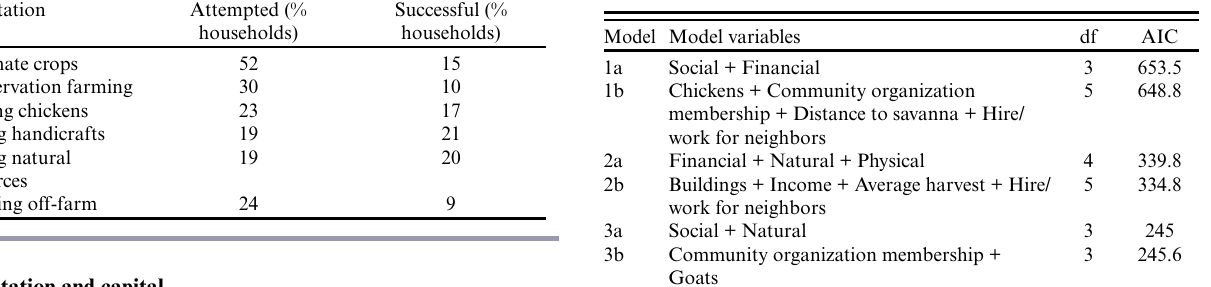
Table 2. Akaike Information Criterion (AIC) and degrees of freedom (df) for the top competing regression models of household adaptation attempts (1a, 1b), adaptation success ratio (2a, 2b), and whether a household had any successful adaptations (3a, 3b) as a function of type of capital and capital indicators. See Appendix 2 for all competing